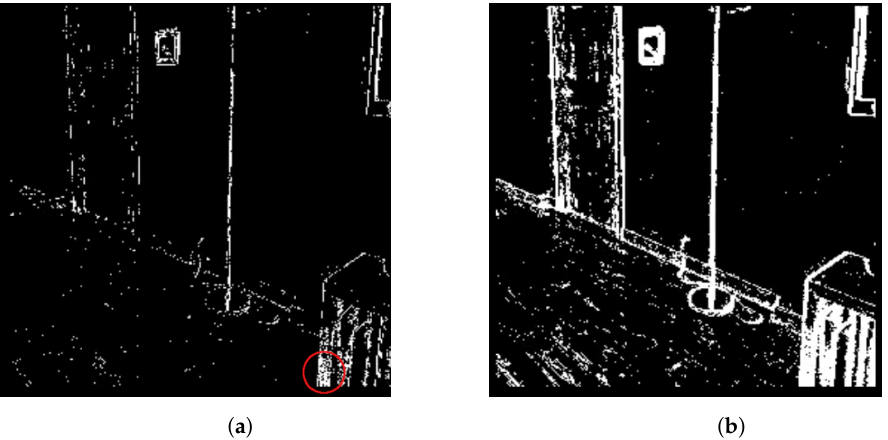
Figure 7. ( a ) Local vs. ( b ) Win20 event selection in the room dataset. Red circle represents the area where the local method conditions are